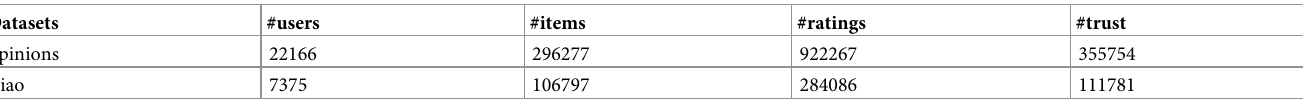
Table 1. Data statistics on two real-world datasets.